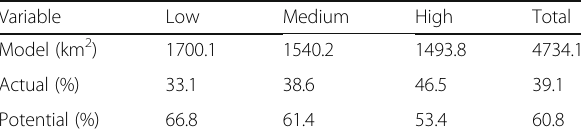
Table 4 Area of each category of the potential habitat suitability map of huemul in Santa Cruz province, classified according to their current occurrence according to field observation data base and the modeled potential distribution, where low is 40 – 50%, medium is 50 – 70%, and high is 70 –